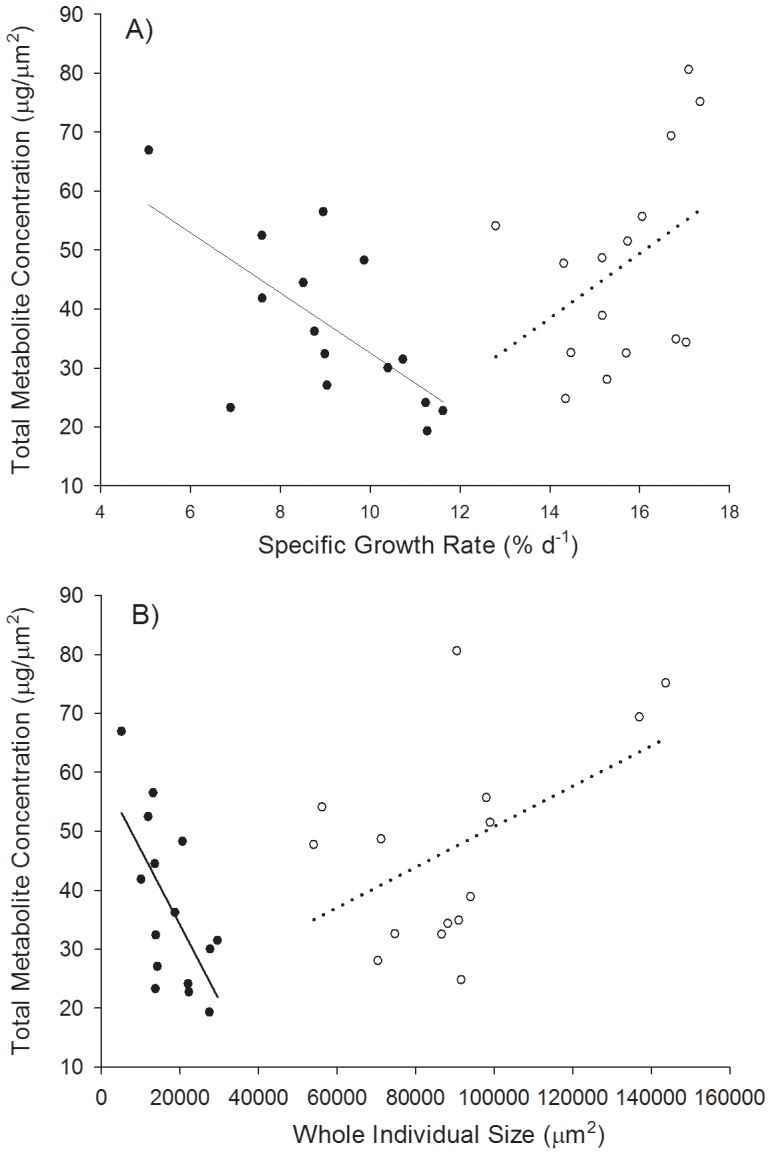
Empirical correlations between total metabolite concentration and growth rate (A) and individual size (B) for 15 families of clones under both low light (solid circles) and moderate light (no fill).Solid lines show significant negative correlations (P<0.05), dotted lines show positive trends (P = 0.13 A, P = 0.07 B).